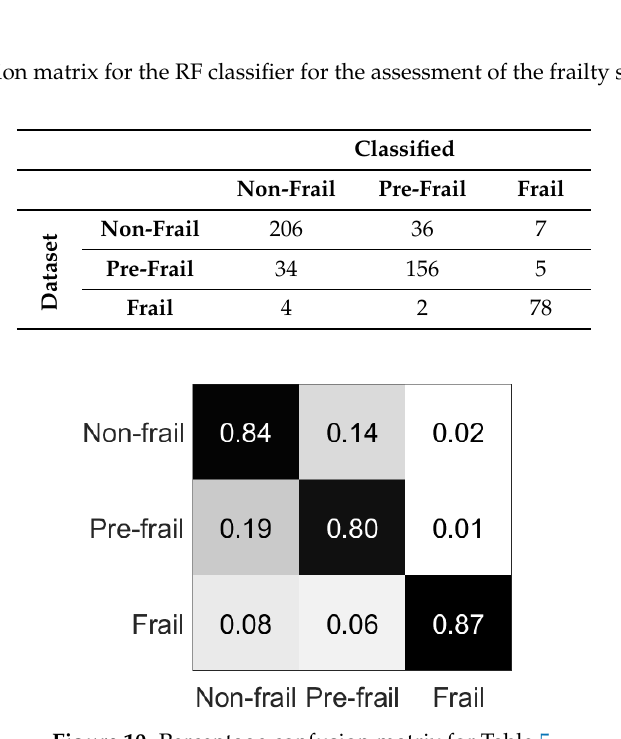
Figure 10. Percentage confusion matrix for Table 5.